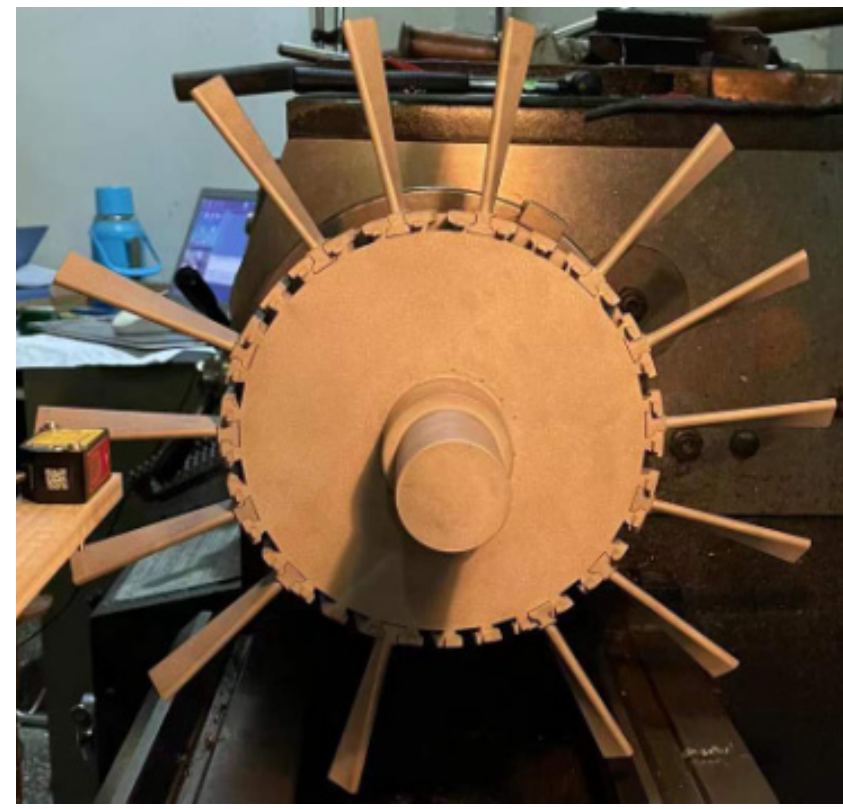
Figure 9. Blade assembly drawing.